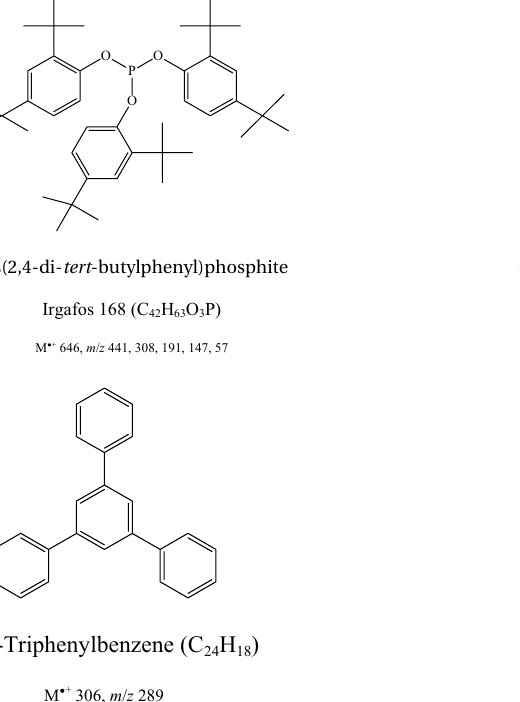
Fig. 3 – Chemical structures of organic tracers in smoke from burning plastics and characteristic mass spectra. For the dominant plasticiser, ions are listed as m / z with relative intensities following in